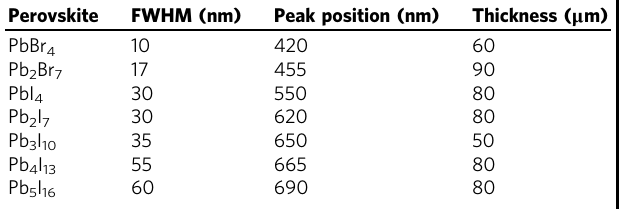
Table 1 Summary of FWHM and peak positions of the narrowband photodetectors extracted from EQE